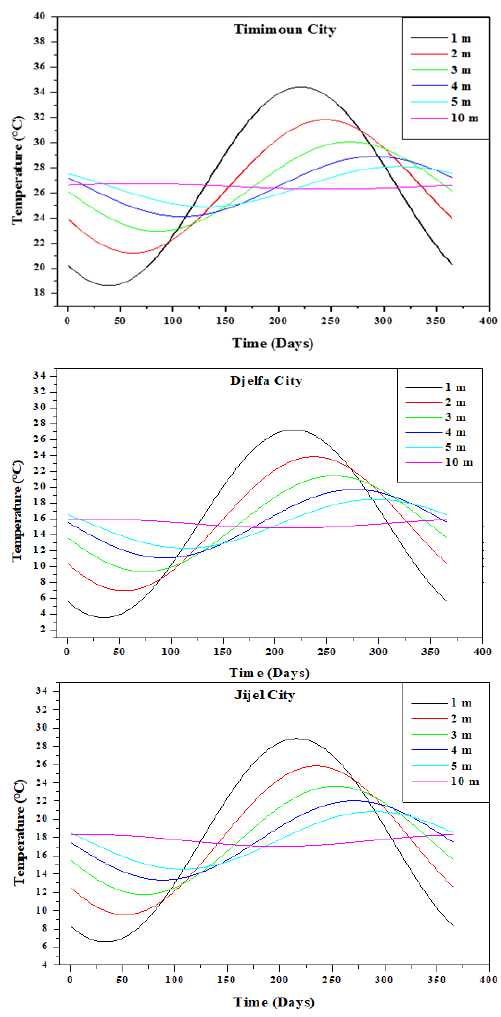
Figure 4. Annual variation of soil temperature in three different Regions.